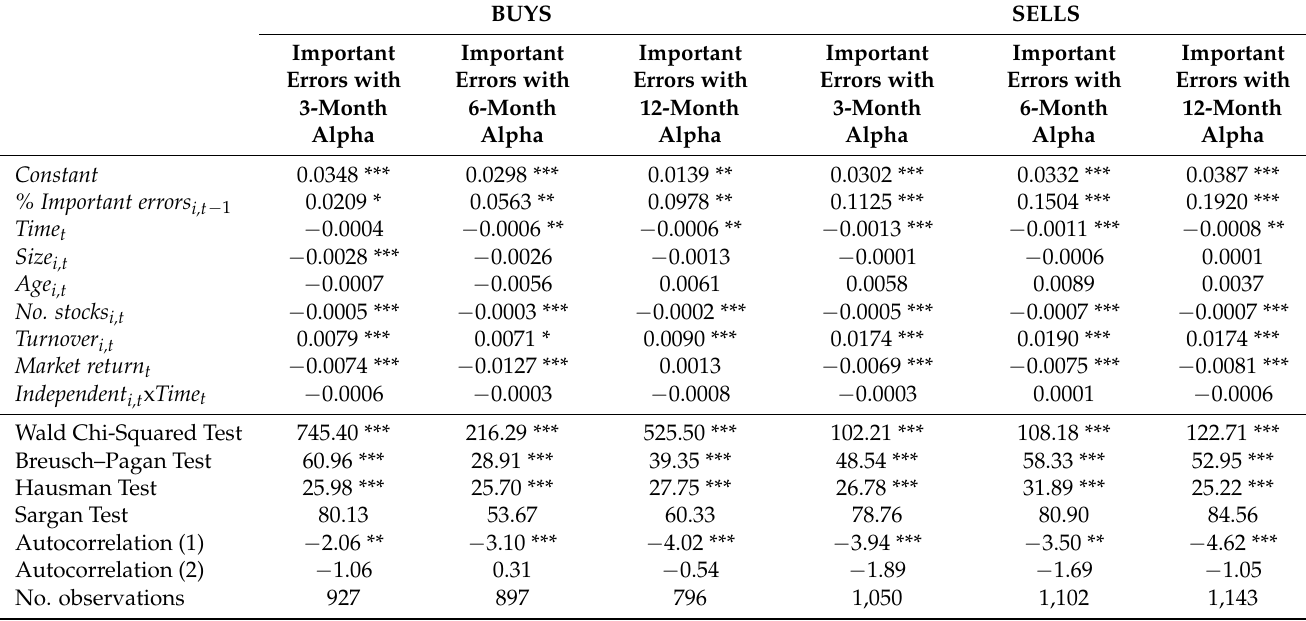
Table 9. Learning results by independence of fund family from financial service groups (Euro non- domestic equity mutual funds). This table presents the results of Equation (15) with the dummy variable named Independent for Euro equity mutual funds from January 2000 to March 2014. The learning results are divided into buys and sells after considering different time horizons to compute the subsequent effect of these errors: 3-month alpha, 6-month alpha, and 12-month alpha. The dependent variable % Important errors i,t − 1 is the 1-year lag of the dependent variable regardless of the time horizon computed. The explanatory variables which are included in this table are: % Important errors i,t − 1 is the 1-year lag of the dependent variable; Time t ranges from 1 in the first year of our sample period to 15 in the last year, the sample period covers from 2000 to 2014. Size i,t is the TNA of mutual fund i divided by the average TNA of all funds included in our sample in year t ; Age i,t is the normalized age of mutual fund i given that we divided the age of each fund by the average age of all funds included in our sample in year t to avoid correlation problems with the time variable; Turnover i,t is the turnover ratio of mutual fund i in year t ; and Market return t is the EuroStoxx-50 total return in year t. We use the EuroStoxx-50 as the benchmark for Euro non-domestic equity mutual funds. Independent i,t xTime t is the interaction between the dummy variable Independent and the